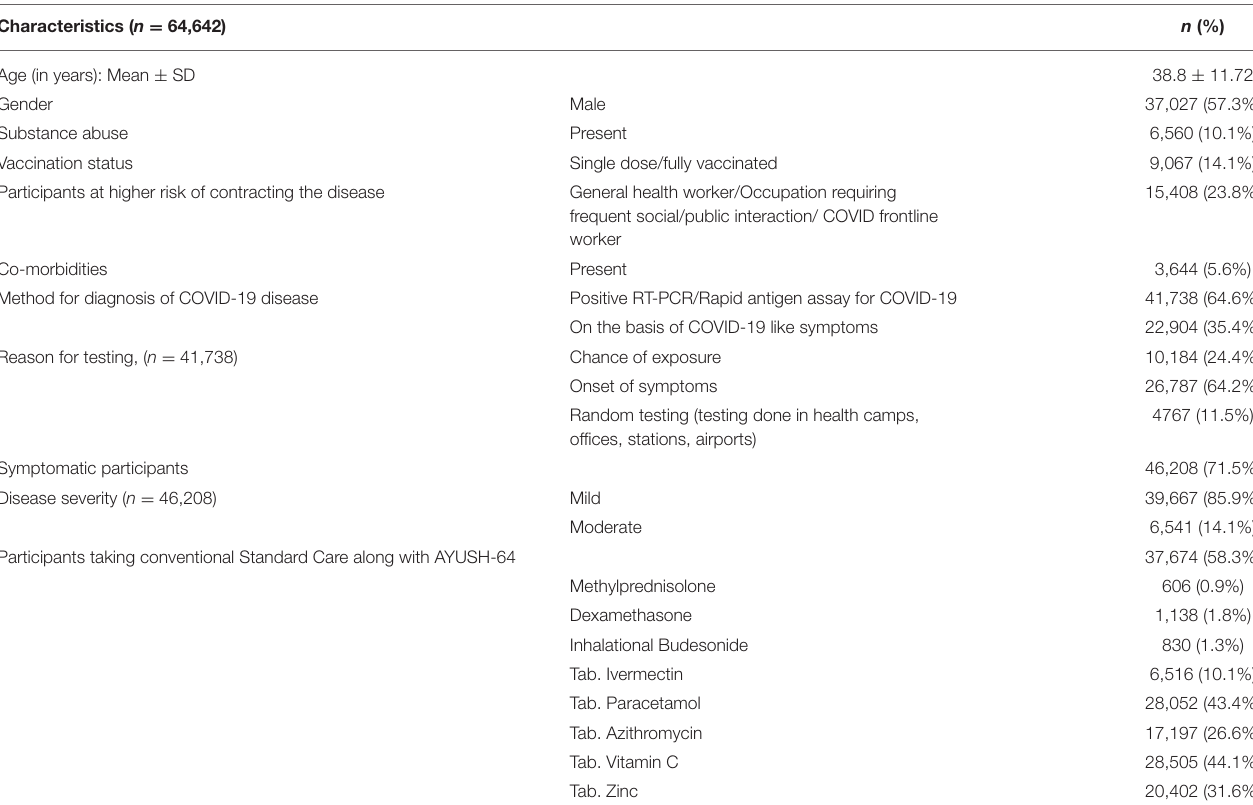
TABLE 1 | Baseline characteristics of the